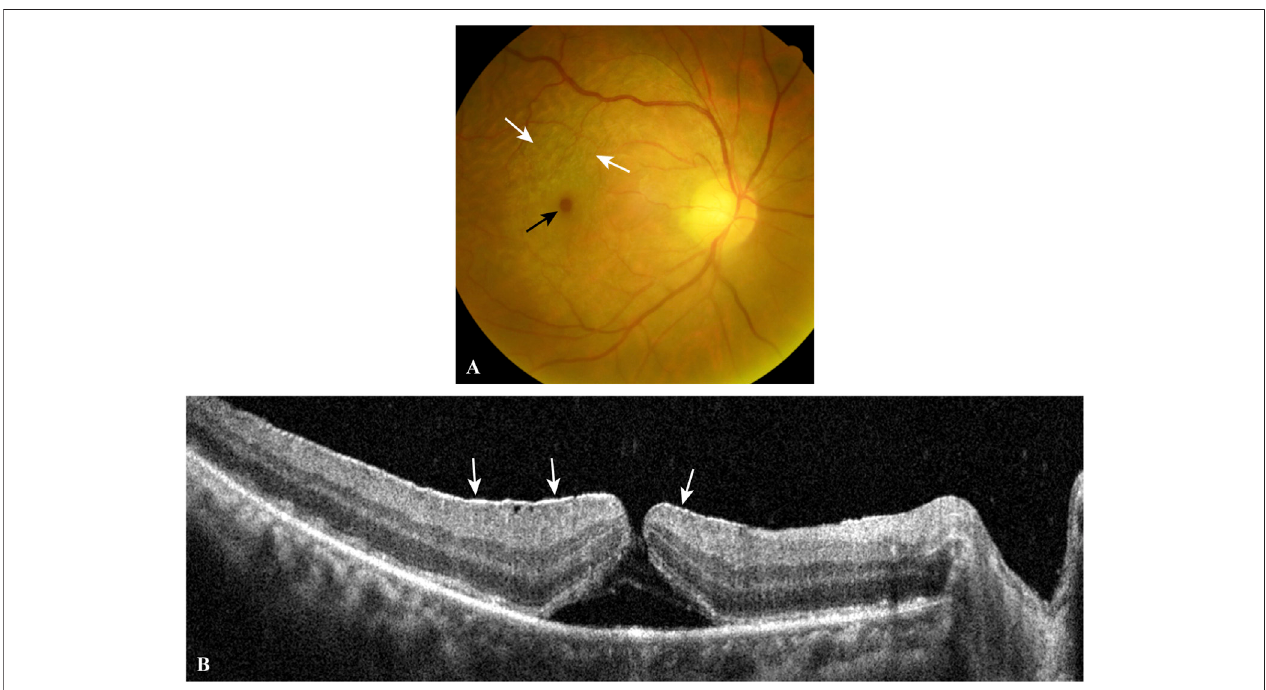
FIGURE 3 | A typical case of EMM complicated by a macular hole. The fundus photograph (A) shows a macular hole (black arrow) and surrounding macular puckers (white arrows) caused by contracted EMMs. OCT scan (B) through the central fovea of (A) demonstrates a contracted EMM (white arrows) causing a macular hole with signi fi cant macular wrinkling and thickening. EMM, epimacular membrane; OCT, optical coherence tomography.